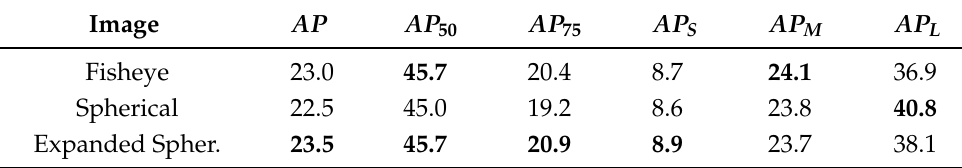
Table 12. Accuracy of different projections of SLCat model on the